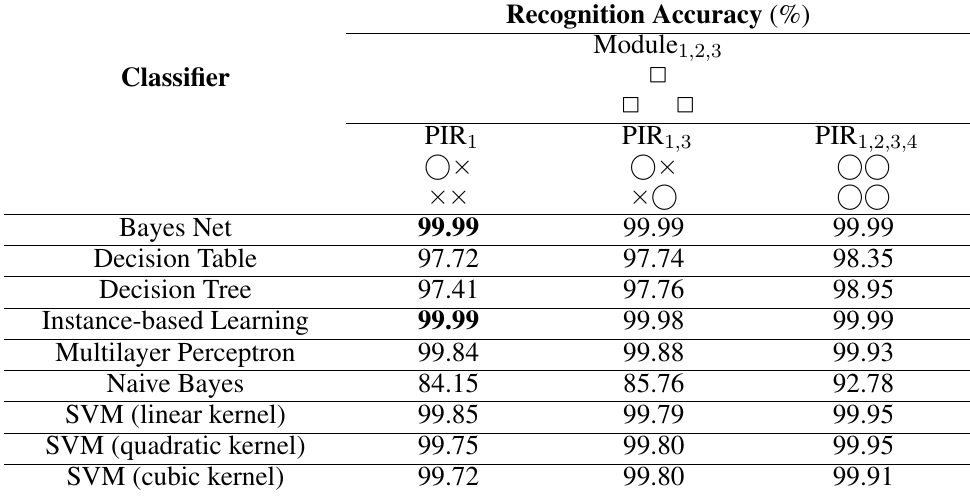
Table 1. Comparison of recognition accuracy (%) of classifying walking directions based on the raw data set with respect to the number of PIR sensors of all